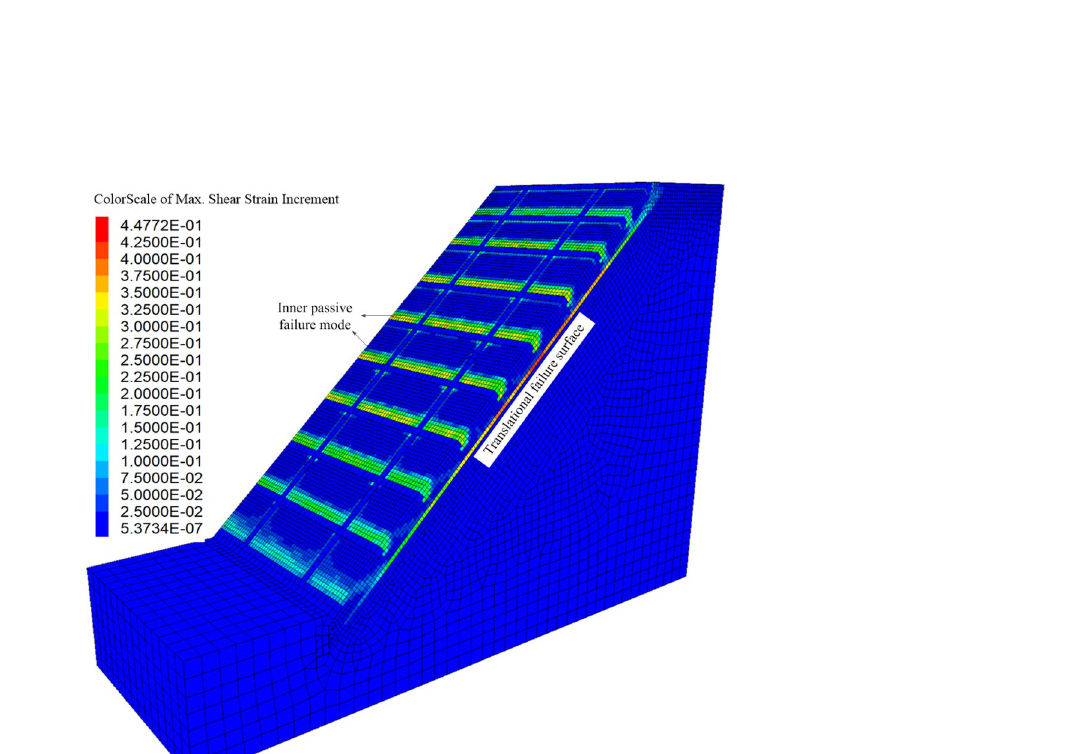
Table 2. Property of soil and concrete material.